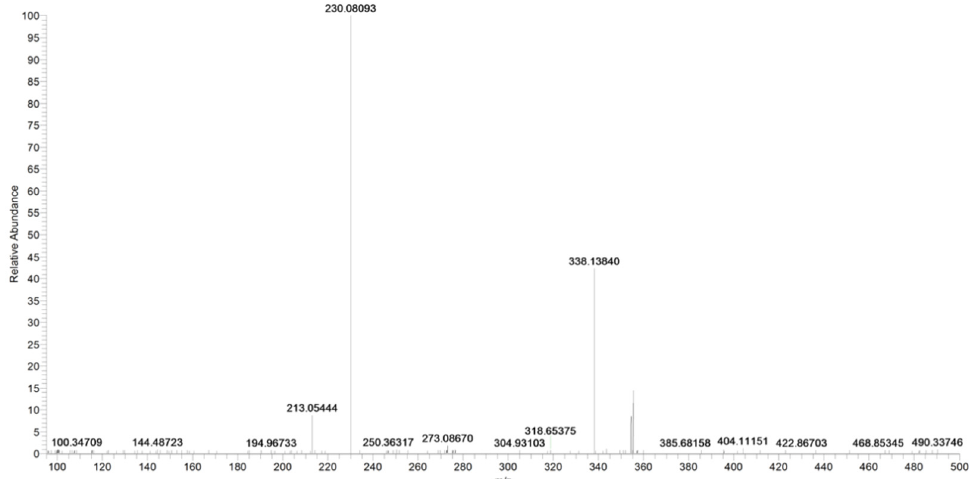
Figure 10 . Product ion scan of URB937 compound obtained by HRMS. Figure 10. Product ion scan of URB937 compound obtained by